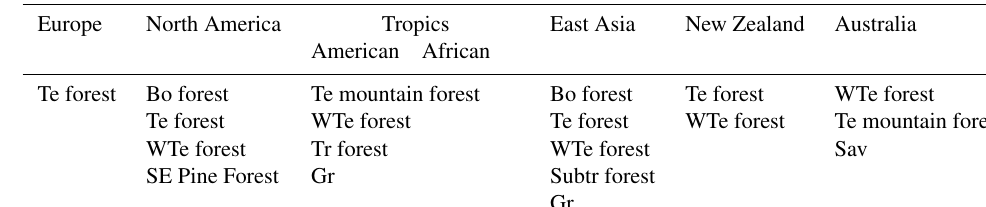
Table 2. Biomes for which the pollen percentages data are included in the ACER database. Bo forest: boreal forest; Te mountain forest: temperate mountain forest; Te forest: temperate forest; WTe forest: warm temperate forest; Tr forest: tropical forest; Subtr forest: subtropical forest; SE Pine forest: southeastern Pine forest; Gr: grasslands and dry shrublands; Sav: savanah. In Europe, Te forest refers to Mediterranean and Atlantic forests.